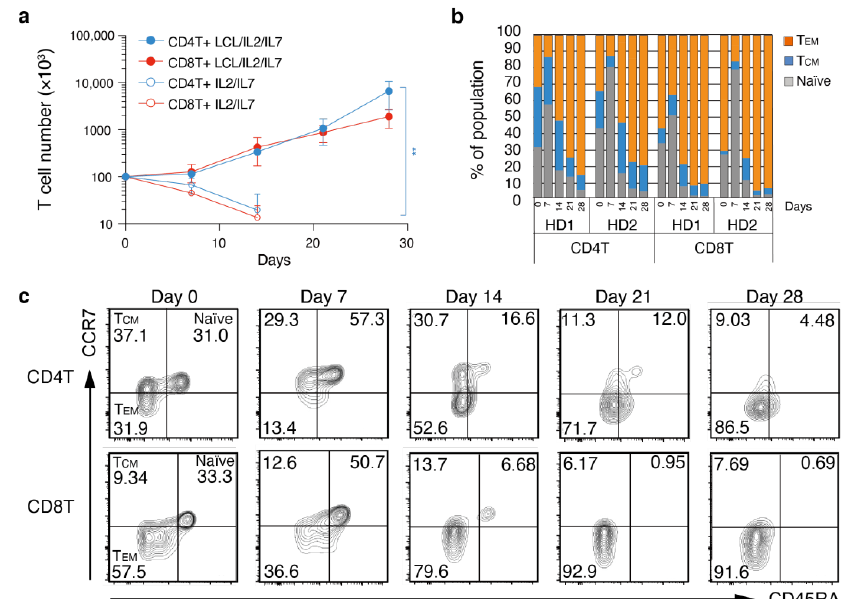
Figure 4. Long-term in vitro expansion and phenotypic analysis of LCL-specific human CD4 + T cells and CD8 + T cells. ( a ) Cell number of CD4 + T cells and CD8 + T cells from two healthy donors (HD1 and HD2) at each time point of co-culture with or without autologous LCL in the presence of 10 ng/mL IL-2 and 10 ng/mL IL-7. Results from four biological replicates in each condition are shown (n = 4). Two-way ANOVA with Tukey post-hoc tests; ** p < 0.01. ( b ) Percentage of CCR7 + CD45RA + naïve, CCR7 - CD45RA - effector memory and CCR7 + CD45RA - central-memory immune phenotype of LCL-stimulated T cells from HD1 and HD2 at the indicated time points (n = 2). ( c ) Representative contour plot of CCR7 and CD45RA expression on CD4 + T cells (upper panels) or CD8 + T cells (lower panels) at the indicated time points. HD1 is shown. ( a – c ) Representative data of more than two independent experiments are shown.